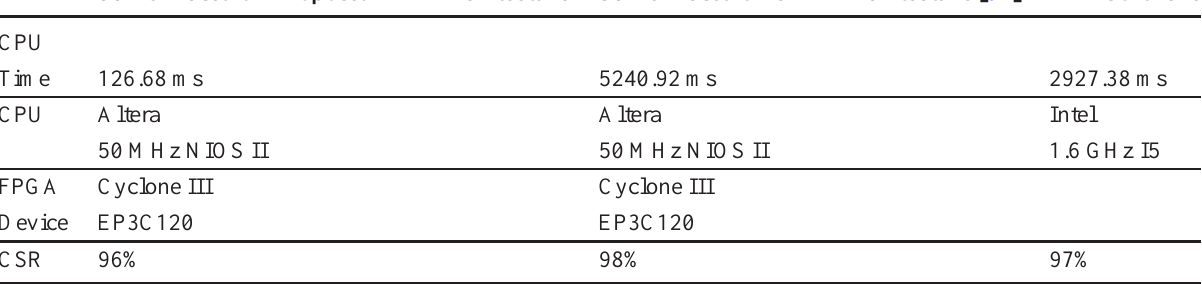
Table 11. Comparisons of various implementations for texture